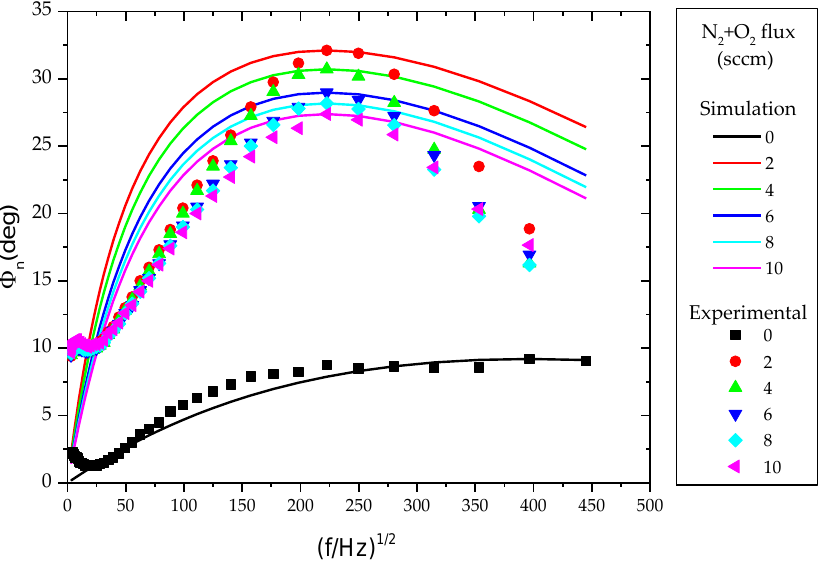
Figure 8. Inverse normalized phase vs. modulation frequency for the N 2 + O 2 flux. The solid lines represent the simulations based on the two-layer model proposed by Fotsing et al. [24].